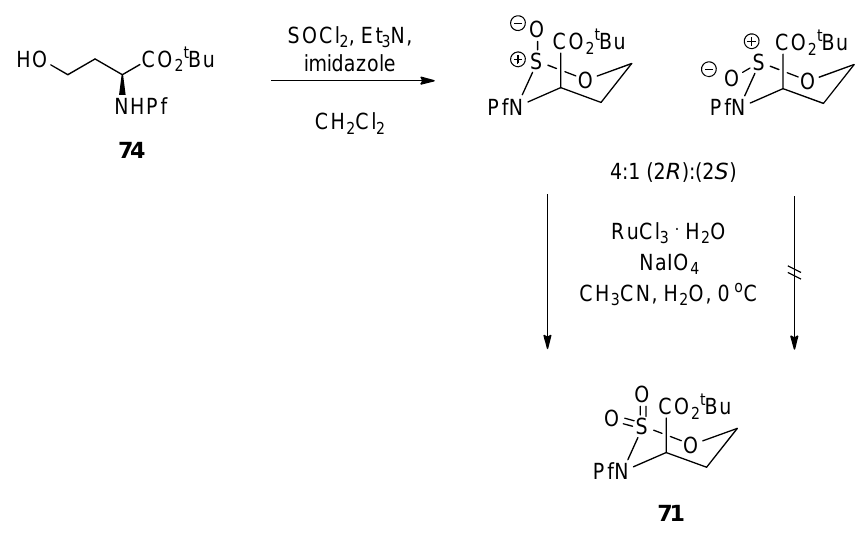
Table 11. Conditions affecting the nucleophilic addition to sulfamidate [37].